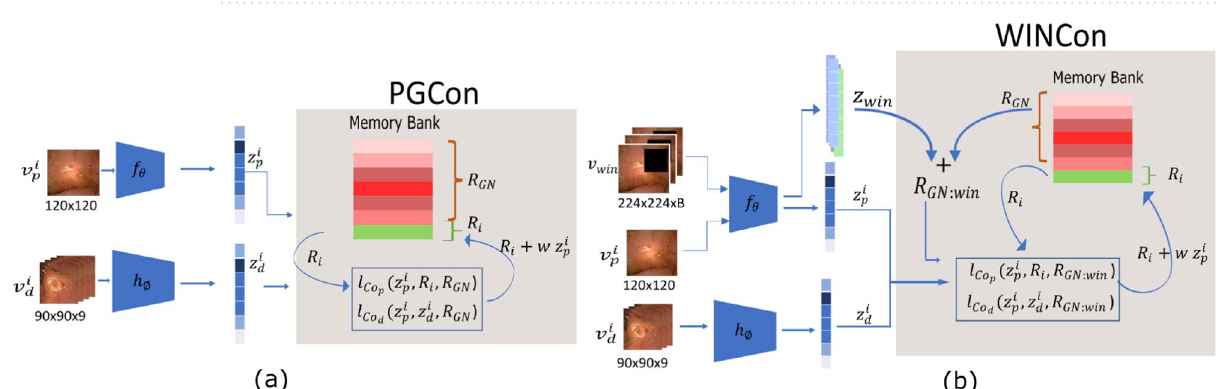
p v d i (prior view) and i (distorted view) constructed p v win derived from all images v d i and i , WINCon uses